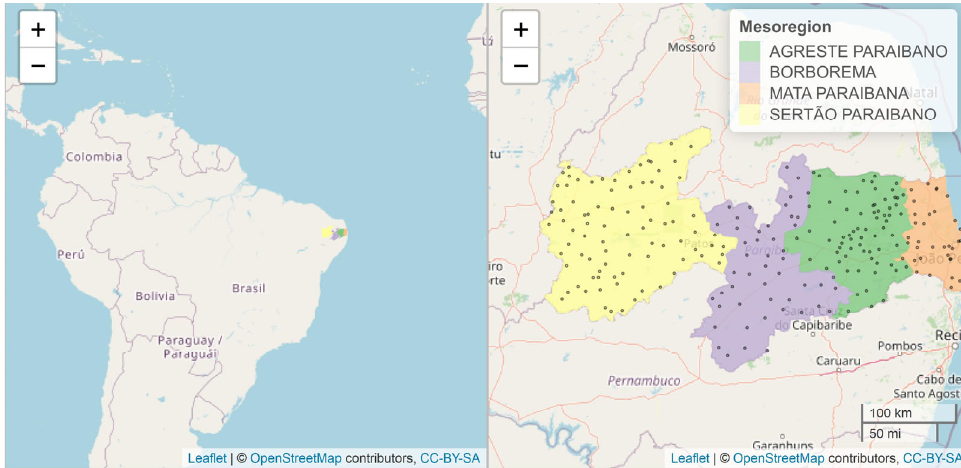
Figure 1. Map of South America ( left side ) with details for the region under study ( right side ) accompanied by the location of the 238 rainfall stations in the state of Paraíba.